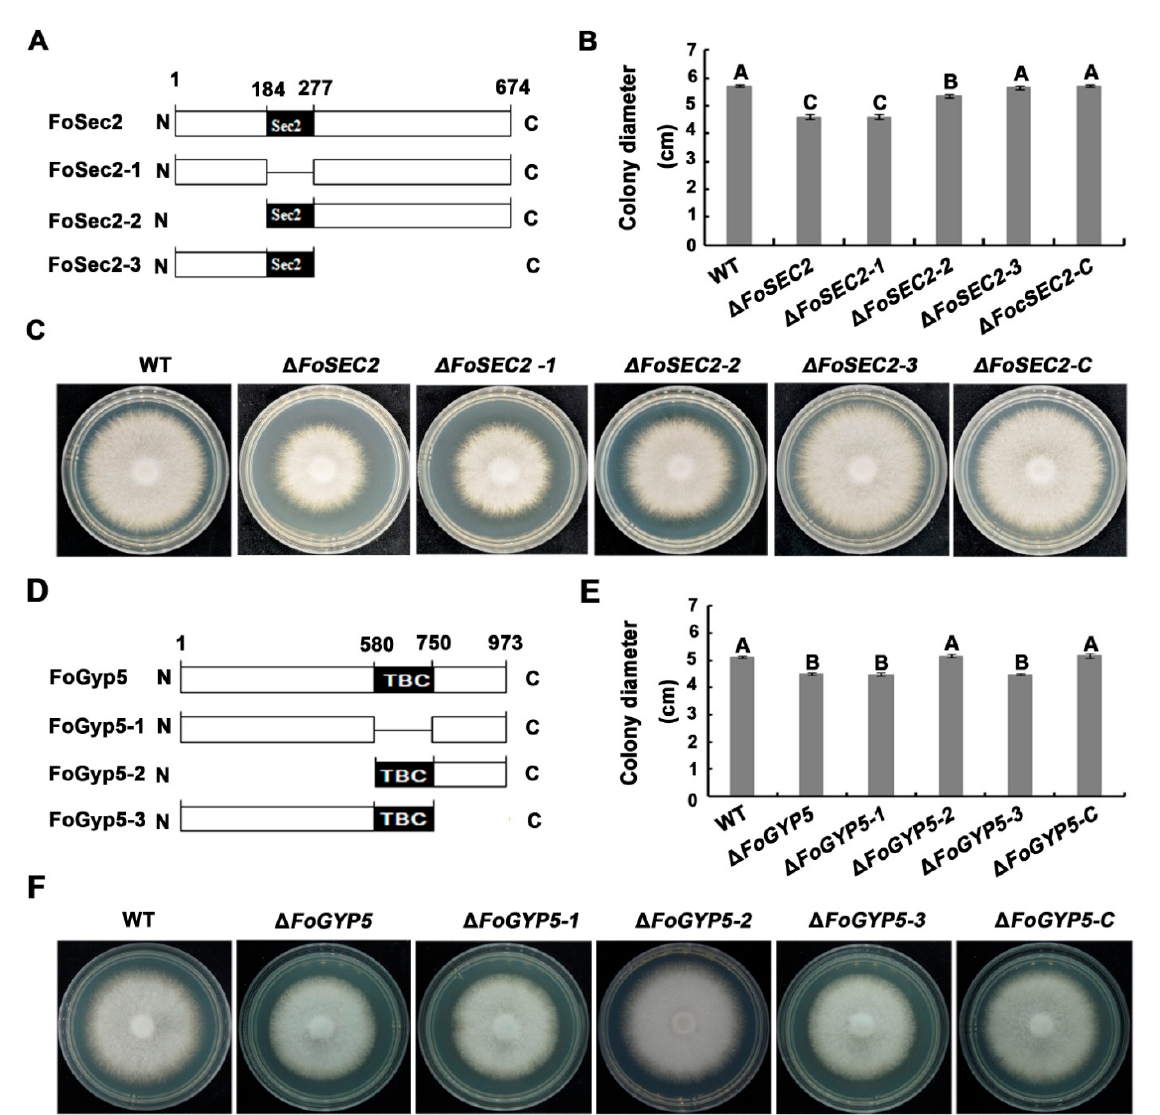
Figure 8. The Sec2 domain and N-termini of FoSec2 were crucial for vegetative growth, and the TBC domain and the C-termini of FoGyp5 were crucial for vegetative growth in F. odoratissimum . ( A ) Schematic drawing of the deletion of the Sec2 domain and the N- and C-termini of FoSec2. ( B ) The colony diameters of all FoSec2 domain deletion mutants. The error bars represent the standard deviation (SD) of three replicates, and the values on the bars followed by the same letter are not significantly different at p = 0.01. ( C ) Colony morphology of all FoSec2 domain deletion mutants on CM for approximately 3 days. ( D ) Schematic drawing of the deletion of the TBC domain and the N- and C-termini of FoGyp5. ( E ) The colony diameters of all FoGyp5 domain deletion mutants. The error bars represent the standard deviation (SD) of three replicates, and the values on the bars followed by the same letter are not significantly different at p = 0.01. ( F ) Colony morphology of all FoGyp5 domain deletion mutants on CM for approximately 3 days.